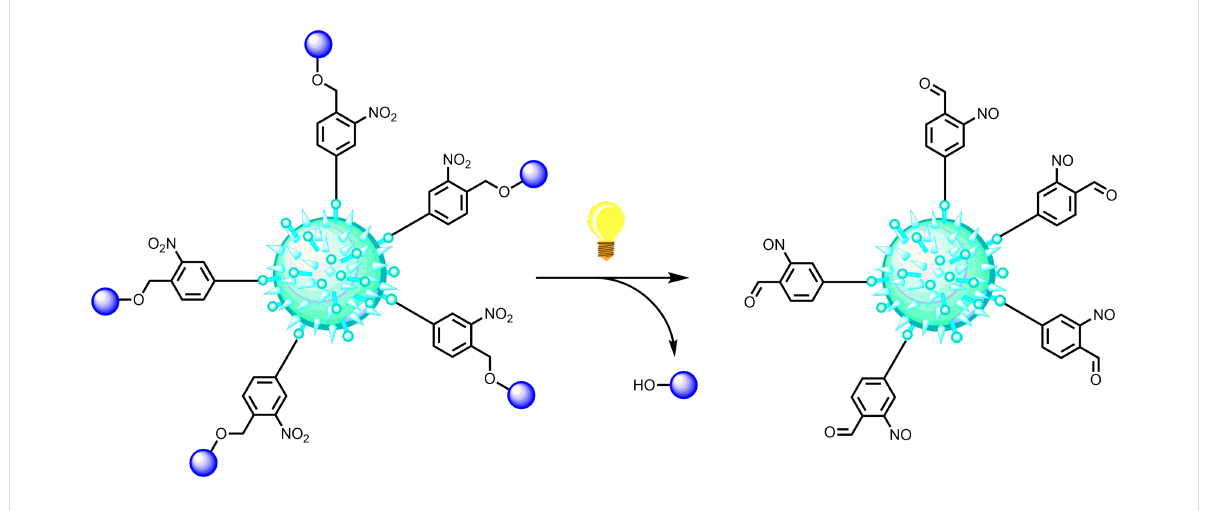
Figure 7: Bond-selective dissociation and photoinduced beam depletion shall enable novel absorptive optical gratings for complex nanobiological ma- terials, which cannot be handled by established optical manipulation techniques based on photoionization. The idea is here illustrated for a nitrobenzyl tagged virus (artist’s